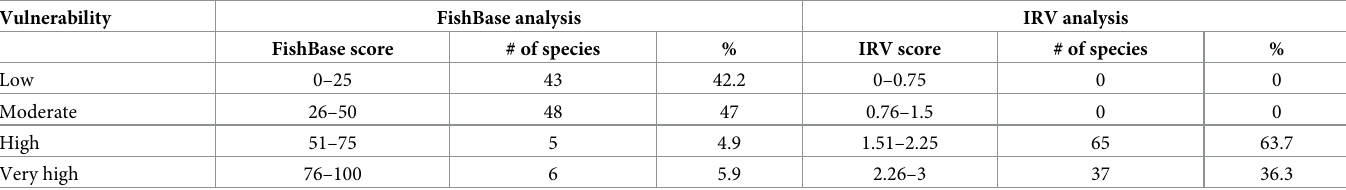
Table 10. Comparison of FishBase [26] and IRV analysis on vulnerability score for 102 teleost fish species.